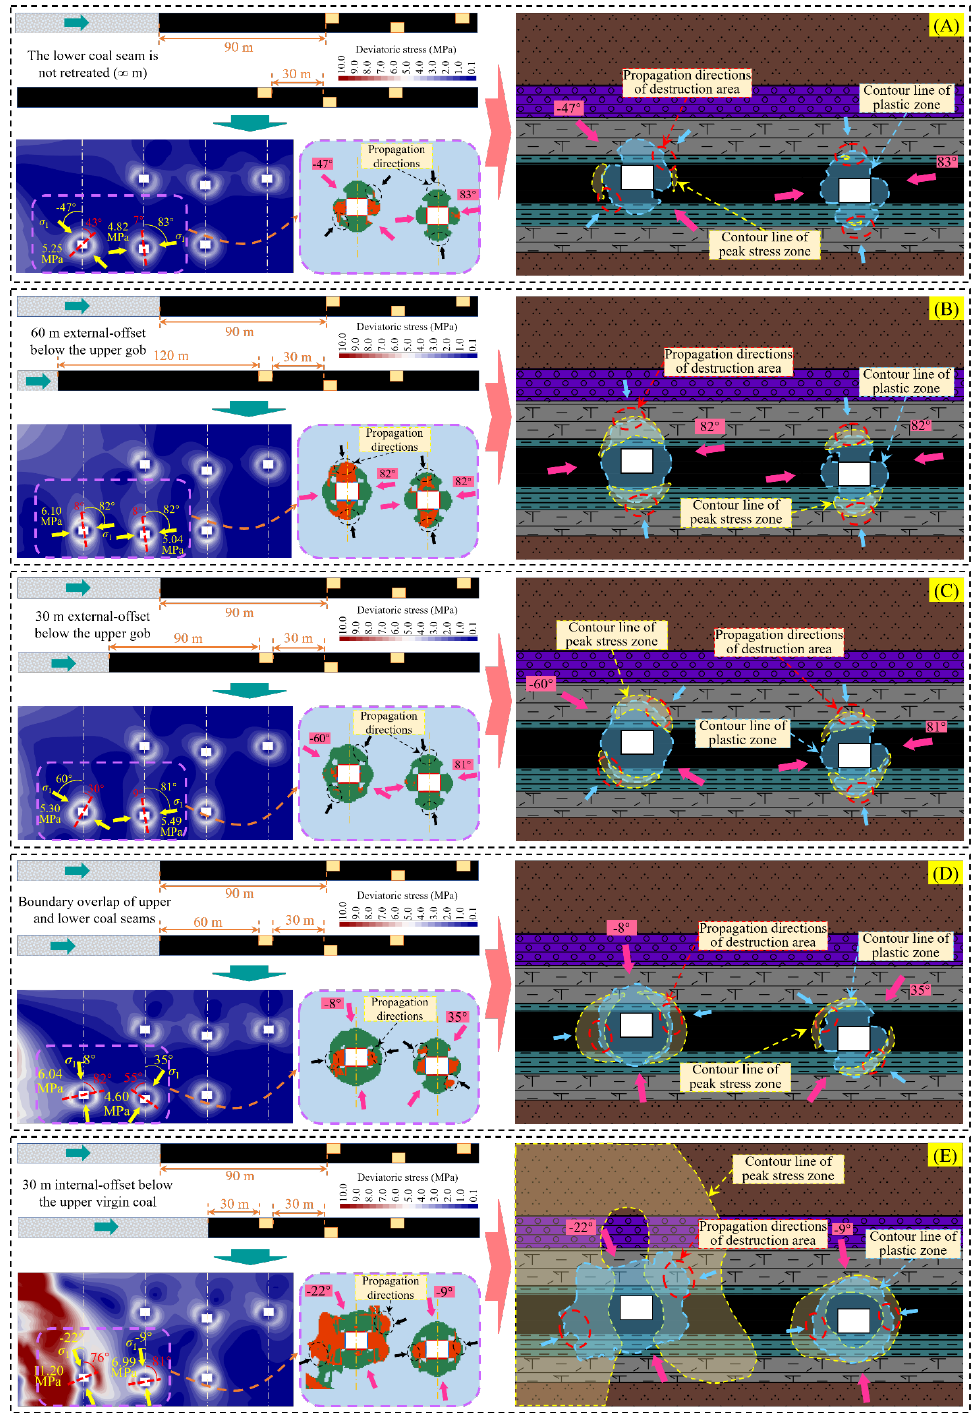
Figure 12. Development characteristics of the deviatoric stress peak zone and plastic zone. ( A – E ) with the protective coal pillar widths of ∞ m, 120 m, 90 m, 60 m, and 30 m, respectively.